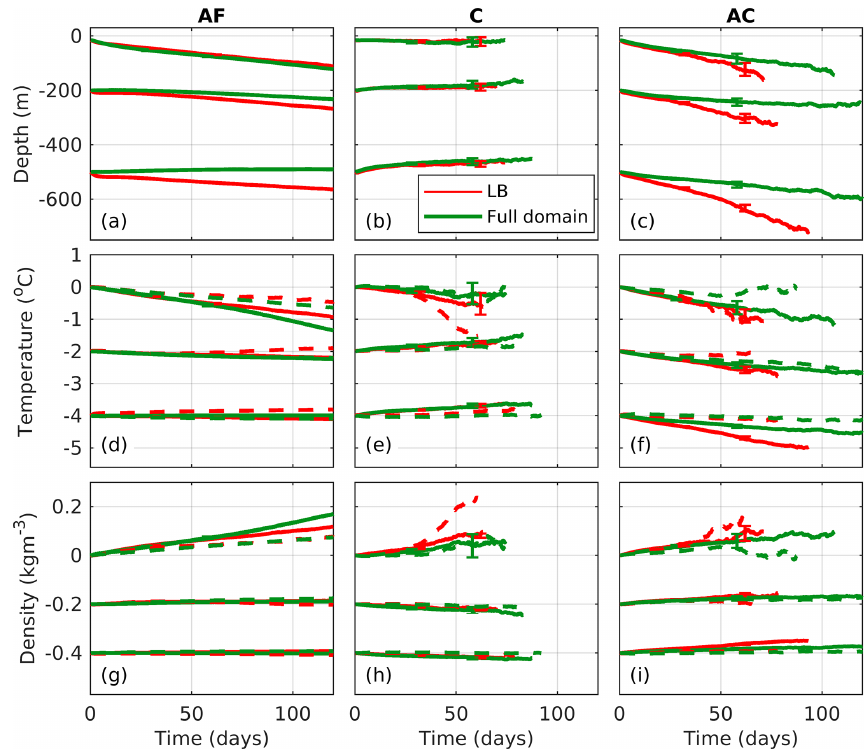
Figure 12. Time series of (a–c) mean vertical displacement for 3D drifters, (d–f) mean temperature change and (g–i) mean density change for 2D (dashed) and 3D (solid lines) drifters. Analyses for the LB (red) and the full domain (green) are shown for the (a, d, g) AF drifters, (b, e, h) cyclonic ridges (C) and (c, f, i) anticyclonic ridges (AC), and for different deployment depths (15, 200 and 500m). To distinguish the drifters that were deployed at 15, 200 and 500m, an offset of − 15, − 200 and − 500m is used for the vertical displacements, 0, − 2 and − 4 ◦ C for the temperature changes, and 0, 0.2 and 0.4kgm − 3 for the density. The mean is based on fewer data points with increasing time, and time series are therefore stopped when the mean is based on fewer than 100 data points. Error bars given as twice the standard error of the mean are given at day 30 and 60 for both the LB (red) and the full domain (green). These are distinguished by using offsets of + 2d for red and − 2d for green. Error bars are only included for the 3D